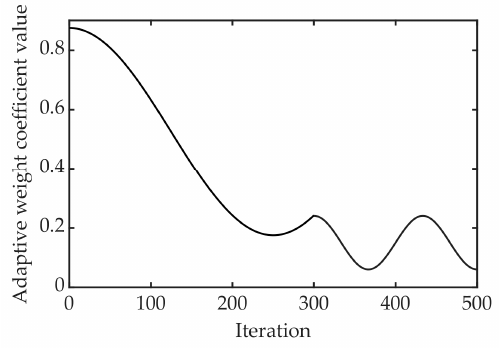
Figure 4. Schematic diagram of adaptive weights.